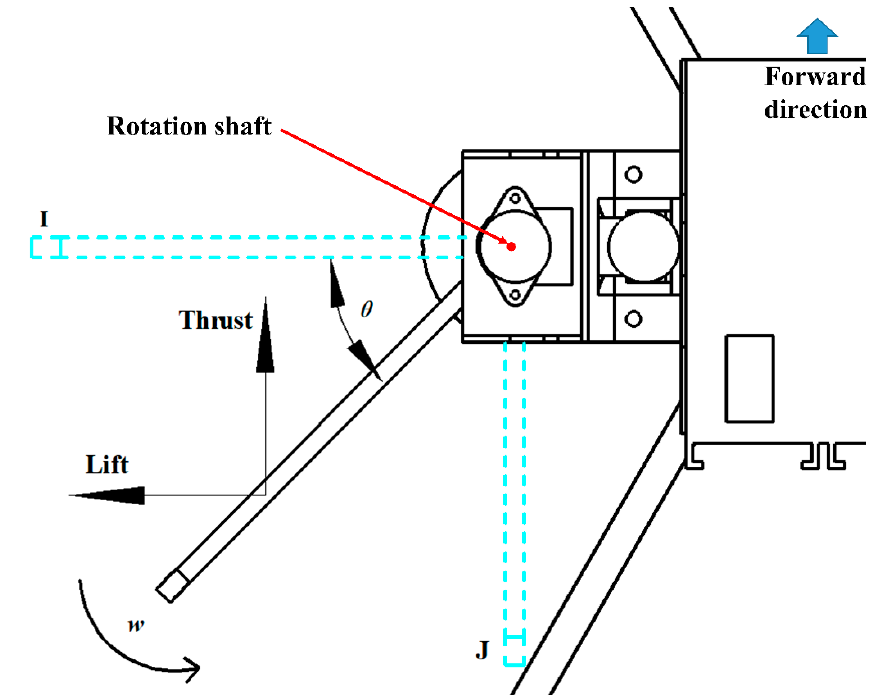
Figure 7. The rotation of the left-side paddle while the robot advances. The approximate directions of the thrust and lift forces generated by the paddle are indicated.